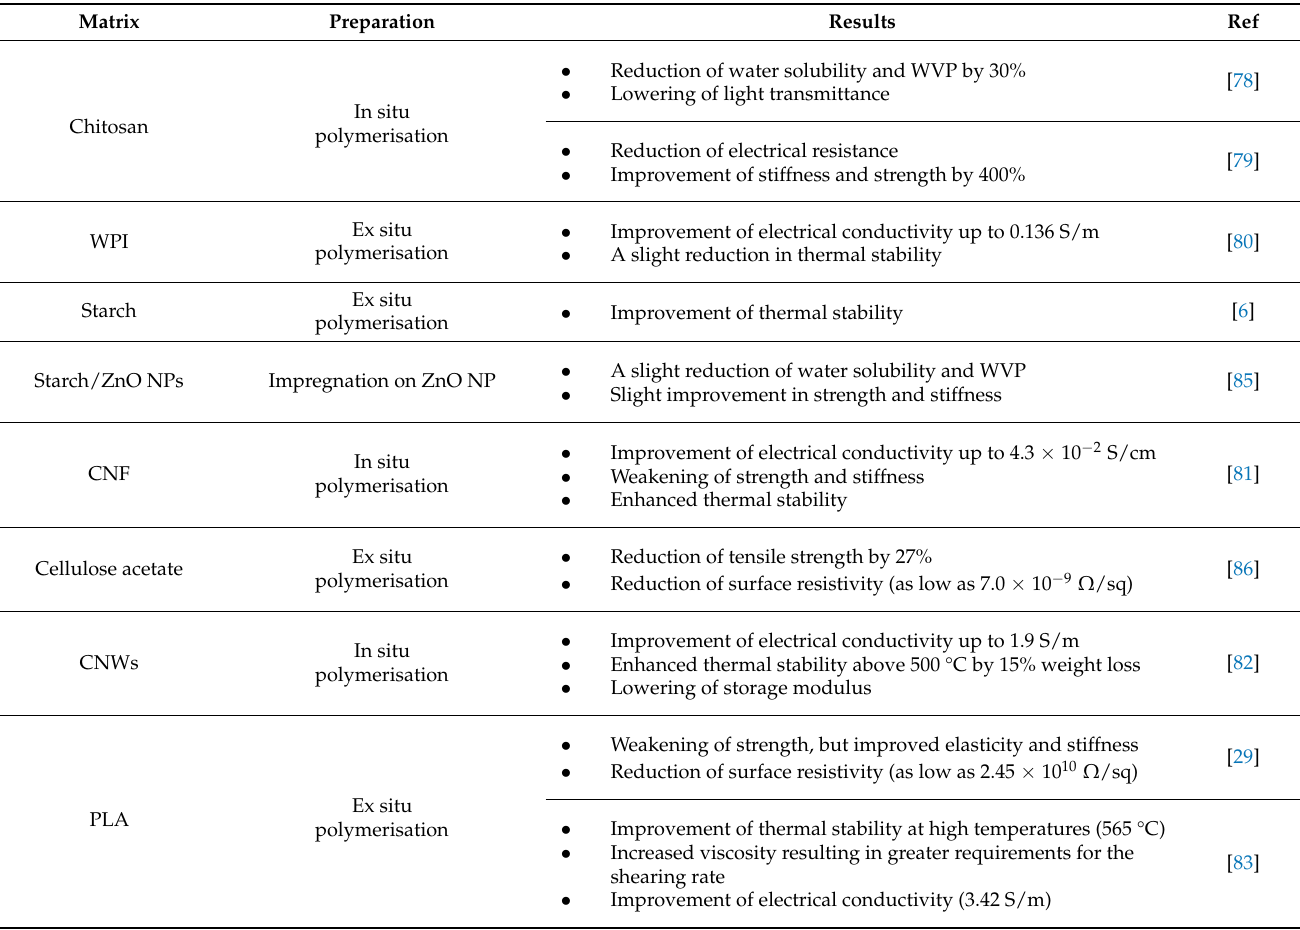
Table 1. Improvement of biodegradable polymer matrices with the incorporation of